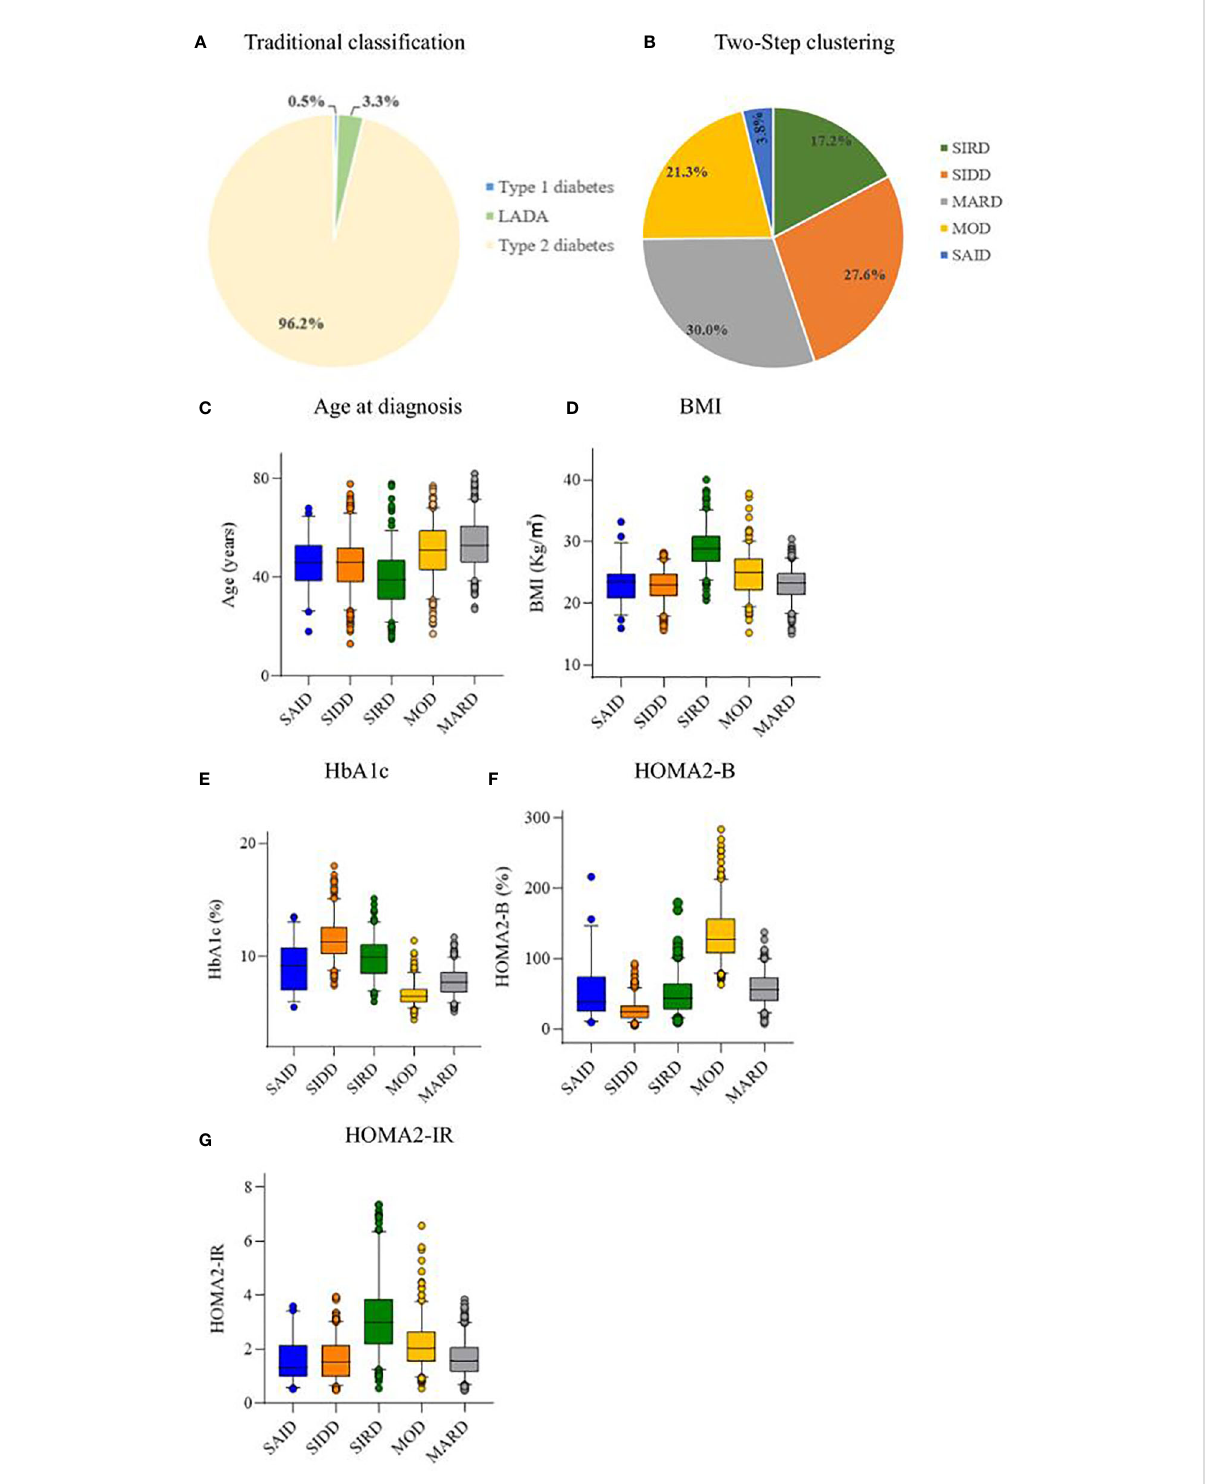
FIGURE 2 Distribution and characteristics of studied patients. (A) Distribution of studied patients according to traditional classi fi cation. (B) Distribution of study patients according to Two-Step clustering. Characteristics of (C) age at diagnosis, (D) body mass index (BMI), (E) hemoglobin Alc (HbAlc), (F) homeostatic model assessment 2 estimates of b -cell function (HOMA2-B), and (G) homeostatic model assessment 2 estimates of insulin resistance (HOMA2-IR) for each cluster. LADA, adult latent autoimmune diabetes; SAID, severe autoimmune diabetes; SIDD, severe insulin- de fi cient diabetes; SIRD, severe insulin-resistant diabetes; MOD, mild obesity-related diabetes; MARD, mild age-related